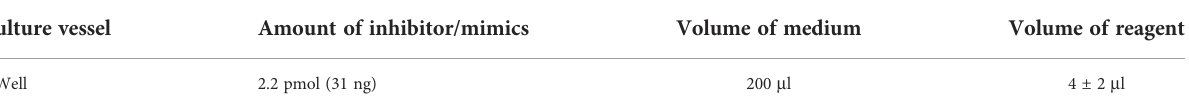
TABLE 2 Transient transfection reaction system.